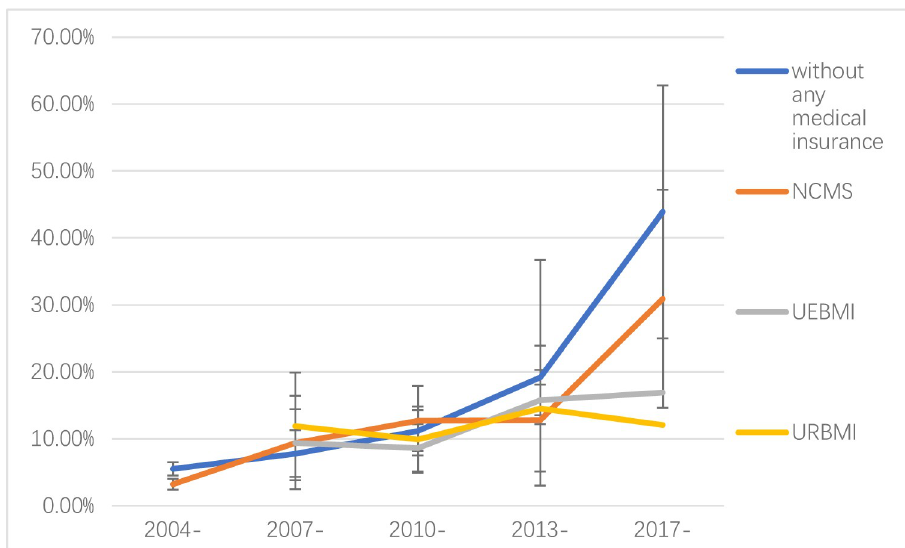
Fig 6. Secular trend of rate of catastrophic health expenditure by types of health